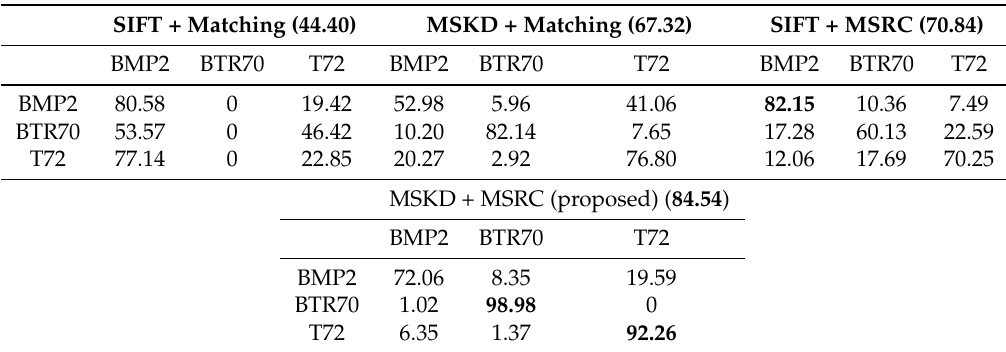
Table 7. Comparison between the confusion matrix (%) of different methods on MSTAR dataset under EOC-1 (configuration variation). SIFT + Matching